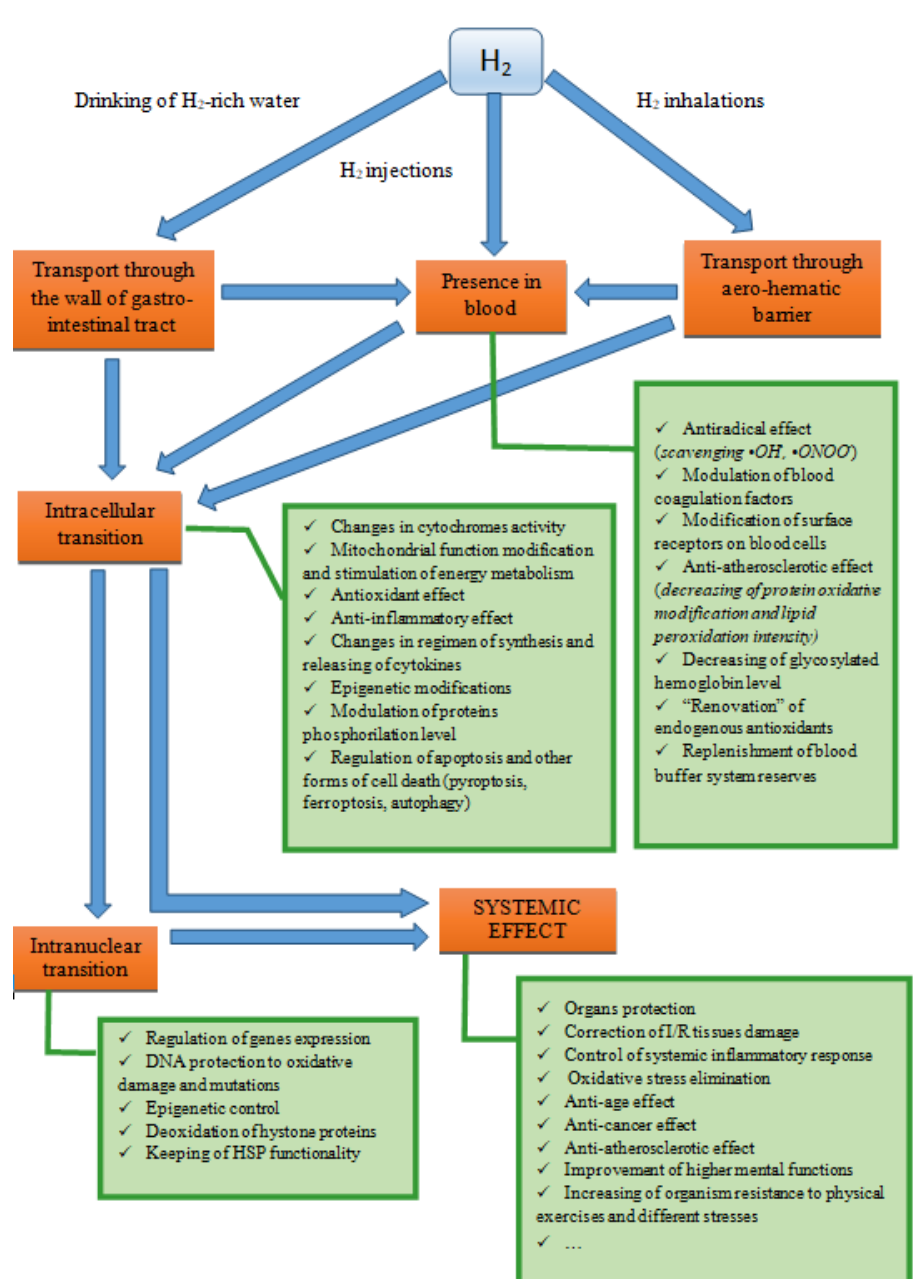
Figure 5. Common cellular, tissue, and systemic effects of molecular hydrogen. The figure demonstrates the pharmacokinetics of molecular hydrogen depending on the route by which it enters the body. In the locations in which hydrogen directly exerts an effect, its molecular mechanisms are shown. Abbreviations: I/R – ischemia and reperfusion, HSP – heat shock protein. In addition, there is evidence for the modulating effect of molecular hydrogen on vari- ous types of metabolism (in particular, lipid, protein, and carbohydrate metabolism) [107]. Perhaps a combination of molecular/cellular, and systemic effects presupposes a regulatory role of H 2 in the management of the state of various cells, including stem